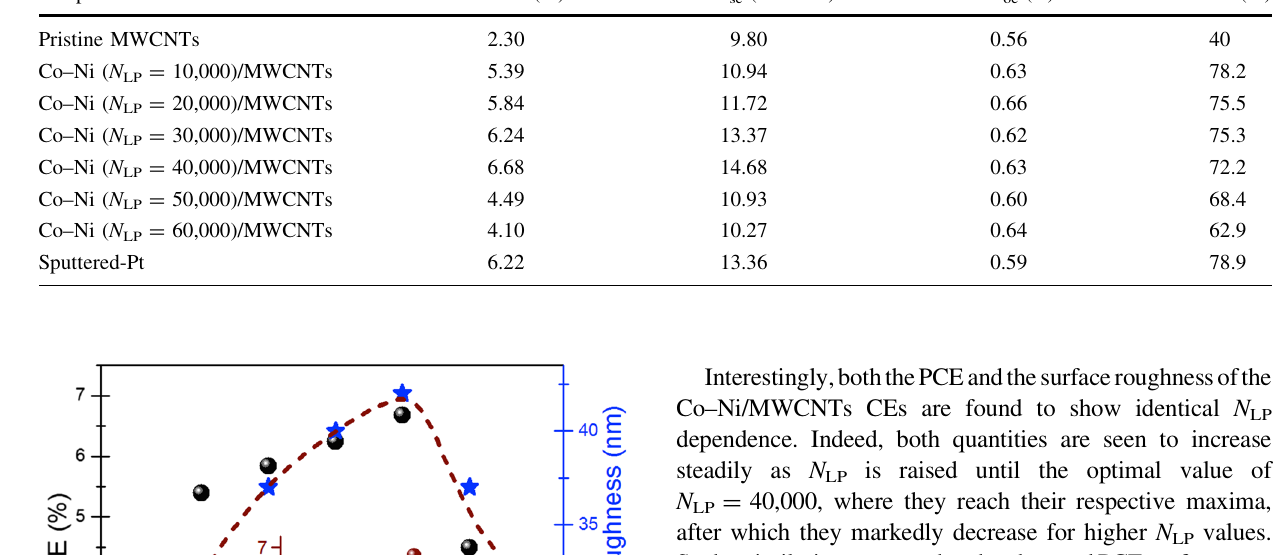
Table 1 Photovoltaic parameters of the DSSCs fabricated with different counter electrodes (i.e., pristine MWCNTs, sputtered-Pt, and Co–Ni NPs decorated MWCNTs at different N LP ), as extracted from the J–V curves of Fig. 5 Sample